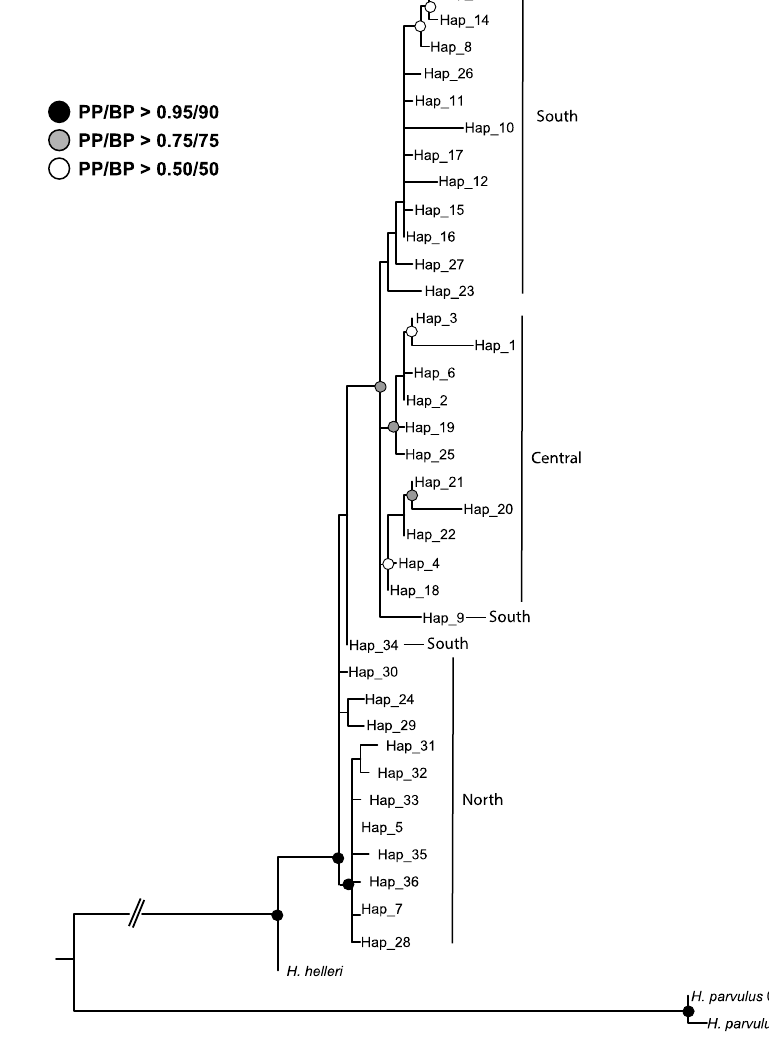
Figure 4. Bayesian inference (BI) and maximum likelihood (ML) topology illustrating relationships between individual haplotypes for H. hydnorae . Labeling of haplotypes by geographic group follows the regions depicted in Figure 2 and Table 1. Hydnorobius helleri and H. parvulus are used as outgroups. PP: posterior probabilities, PB: bootstrap